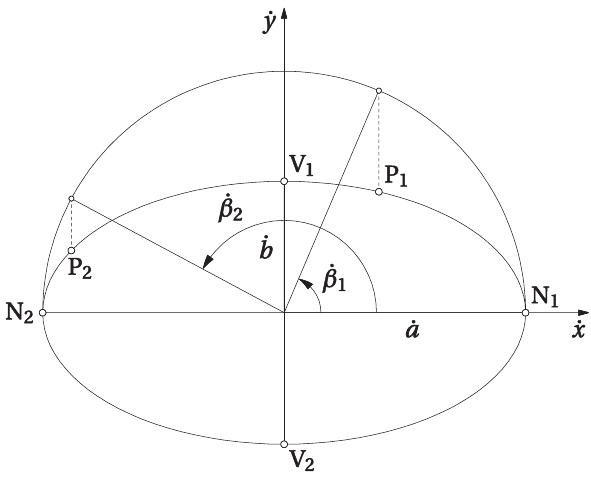
Figure 3. Elliptical section in a plane coordinate system xy  . Vertices, nodes and the parametric angles of points 1 P and 2 P are indicated by